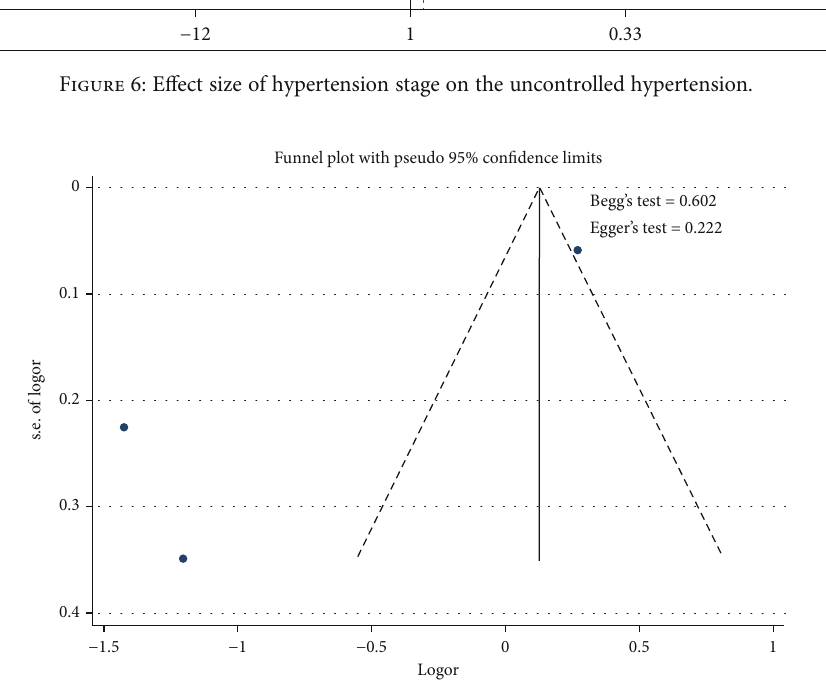
Figure 7: Funnel plots role of hypertension stage on uncontrolled hypertension.